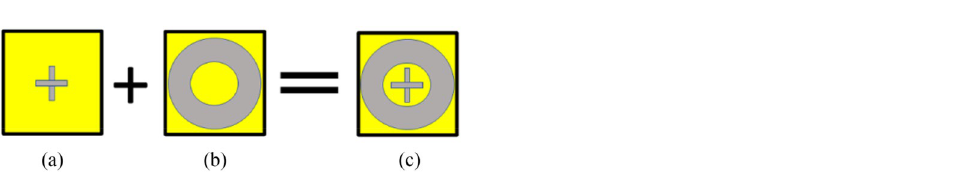
Figure 1. Proposed FSS unit cell geometry, ( a ) incidence of EM wave on FSS Panel, ( b ) top view, ( c ) bottom view, ( d ) side view, ( e ) equivalent circuit model.